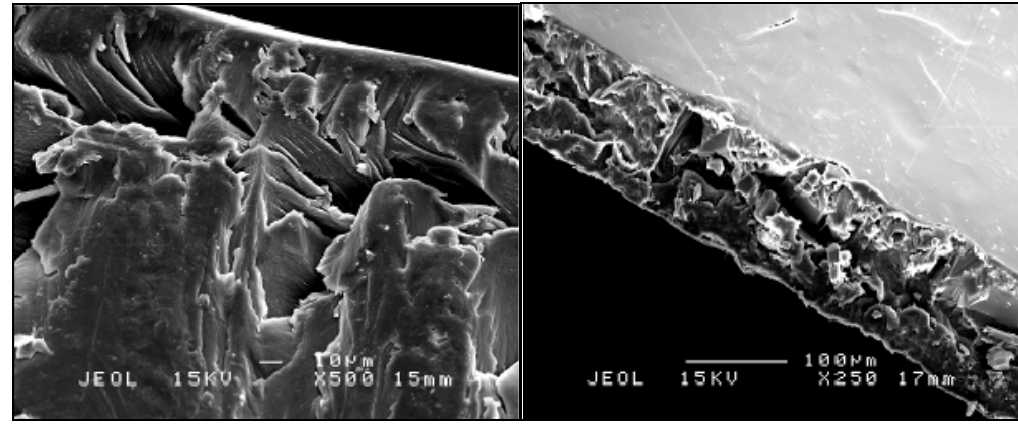
Figure 4. SEM image of the cross section of CA-MIP and PS-MIP.